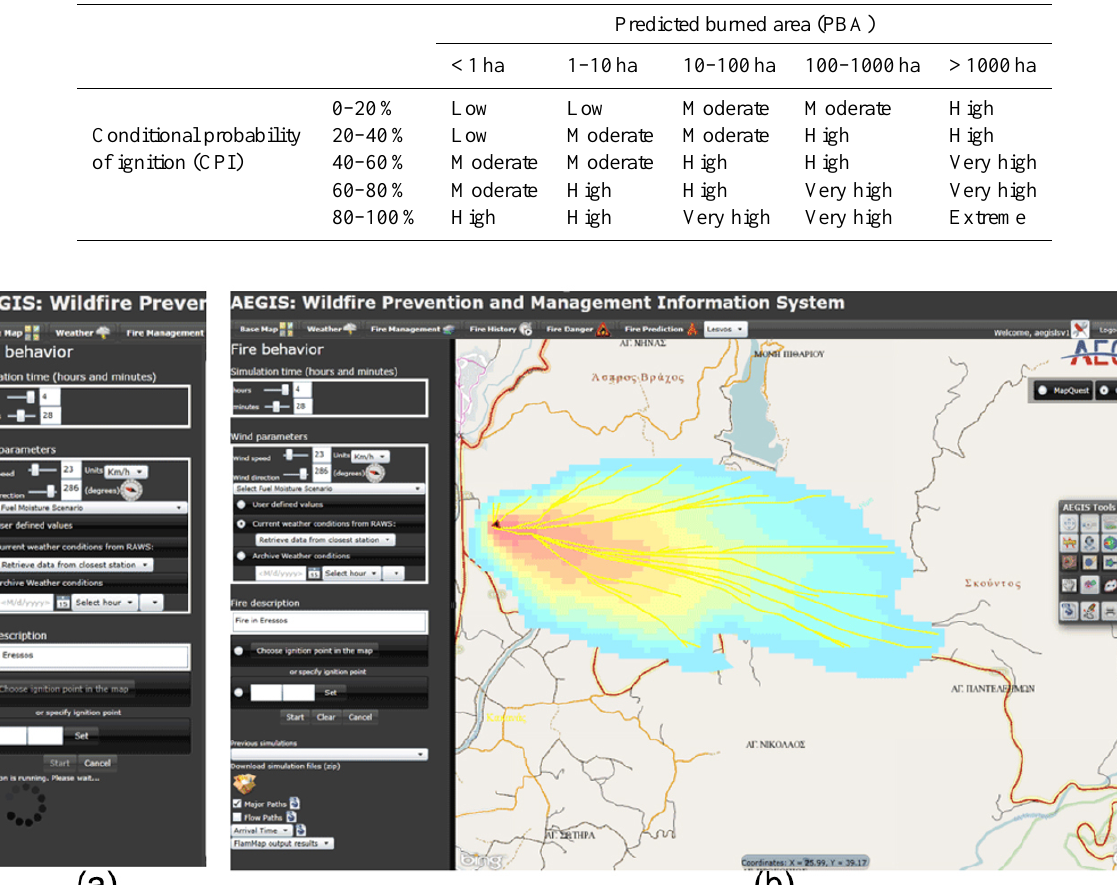
mapping schemes (Bing Maps or Open Street Maps).